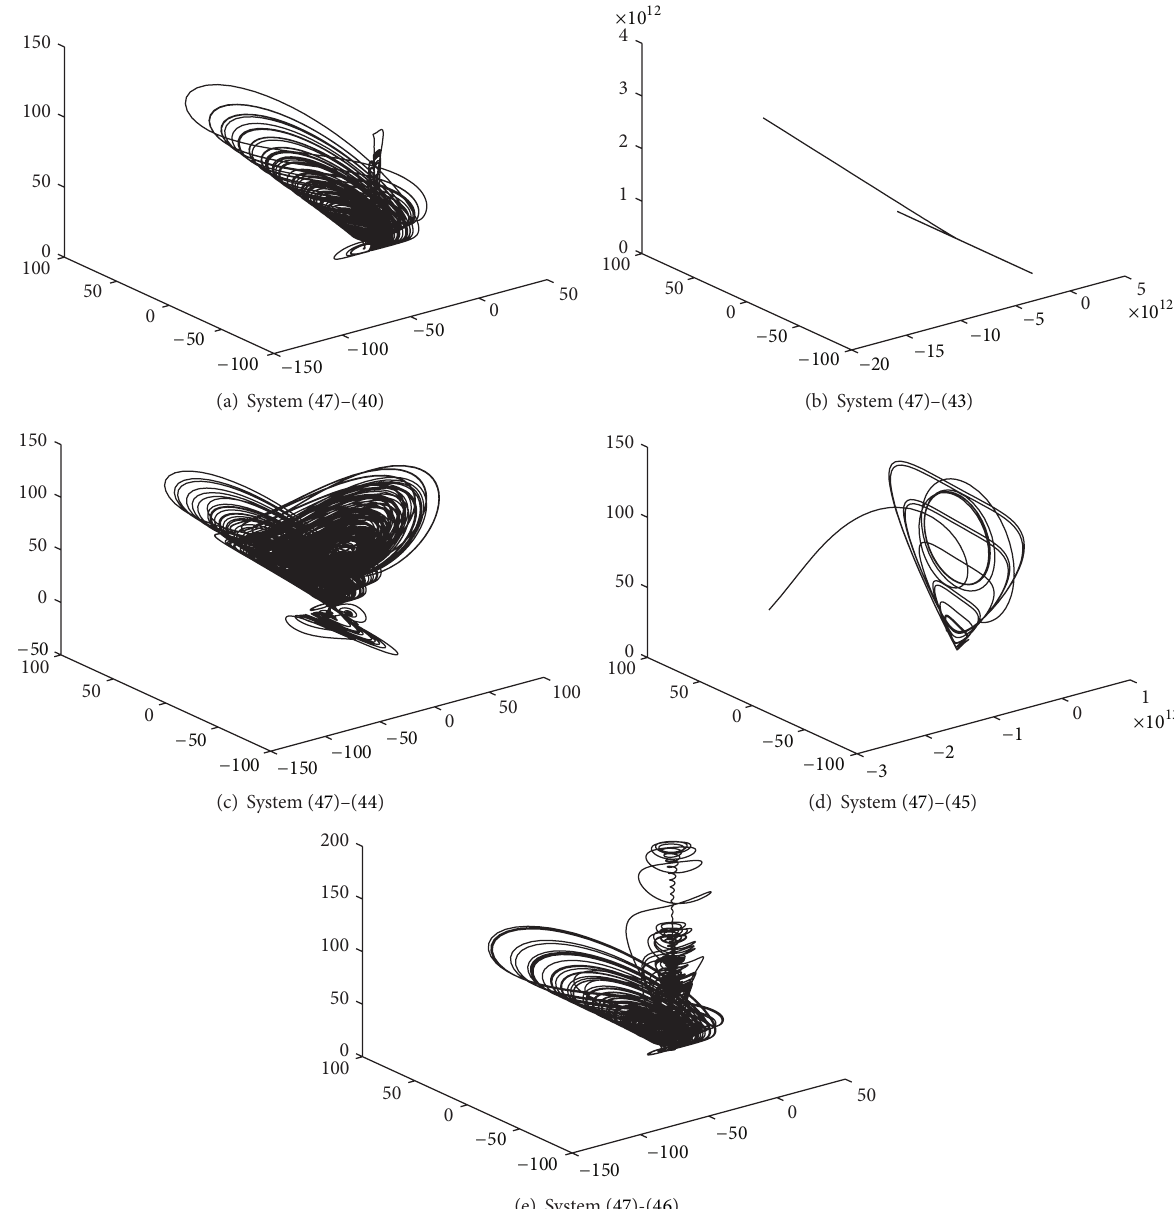
Figure 12: Switched system between Example (47) and